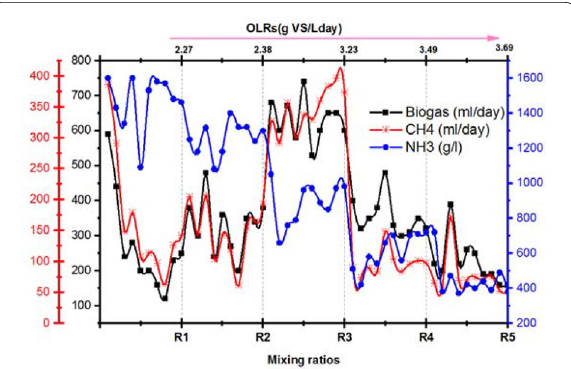
Fig. 8 Methane production versus free ammonia